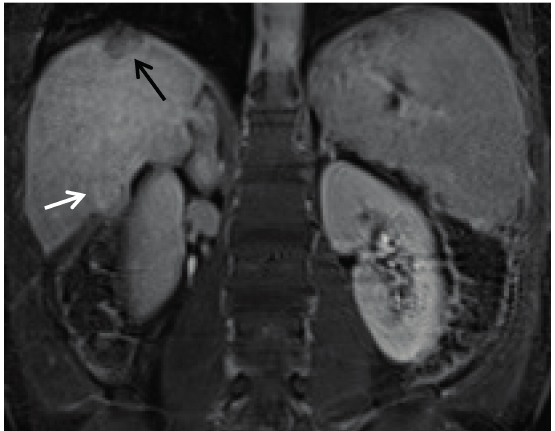
Figure 4. Gadoxetic acid contrast distinguising benign arterial hyperenhancement of cirrhosis versus HCC. ( A ) On the subtracted late arterial phase Gadoxetic acid enhanced study there are 2 areas of hyperenhancement (black and white arrows); ( B ) The hepatobiliary phase from the same exam the shows the low signal area of the HCC (black arrow) but the normal hepatic uptake and therefore normal signal intensity in hepatic segment IV (white arrow), consistent with benign vascular shunting. Subsequent exams (not shown) demonstrated the loss of the segment IV arterial contrast enhancement with the continued presence of normal hepatic uptake in this area.